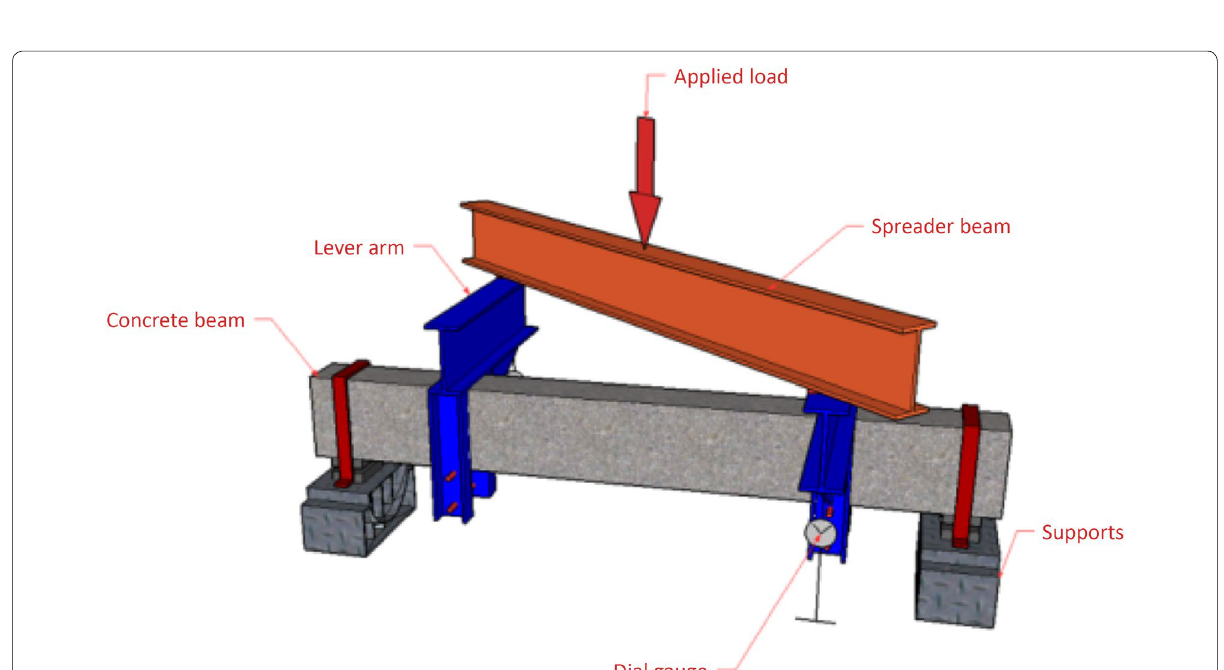
Fig. 6 Schematic of the test setup for applying combined torsion and